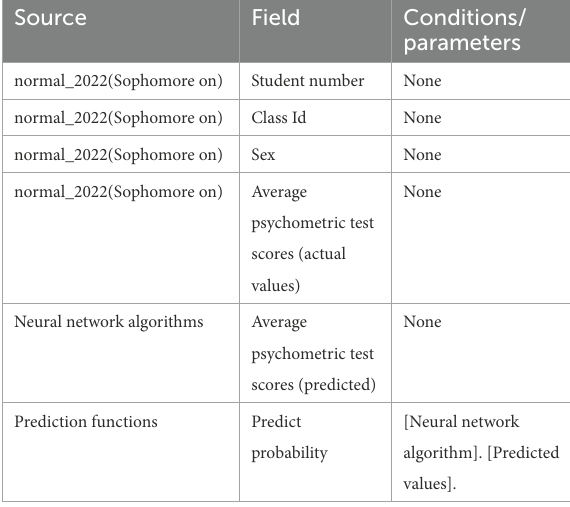
TABLE 2 Structure of the predicted